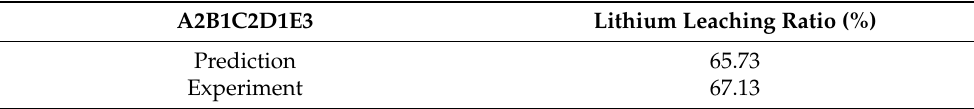
Table 7. Results of the confirmation experiment for lithium leaching